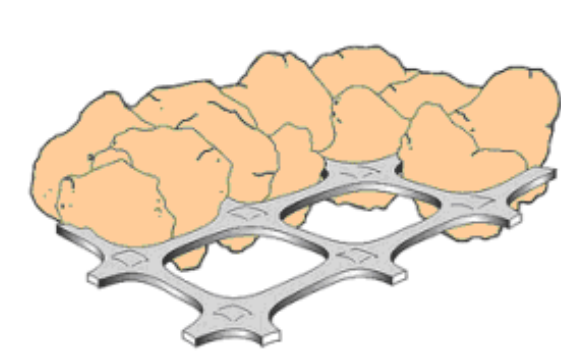
Figure 2. Reinforced geogrid Tensar